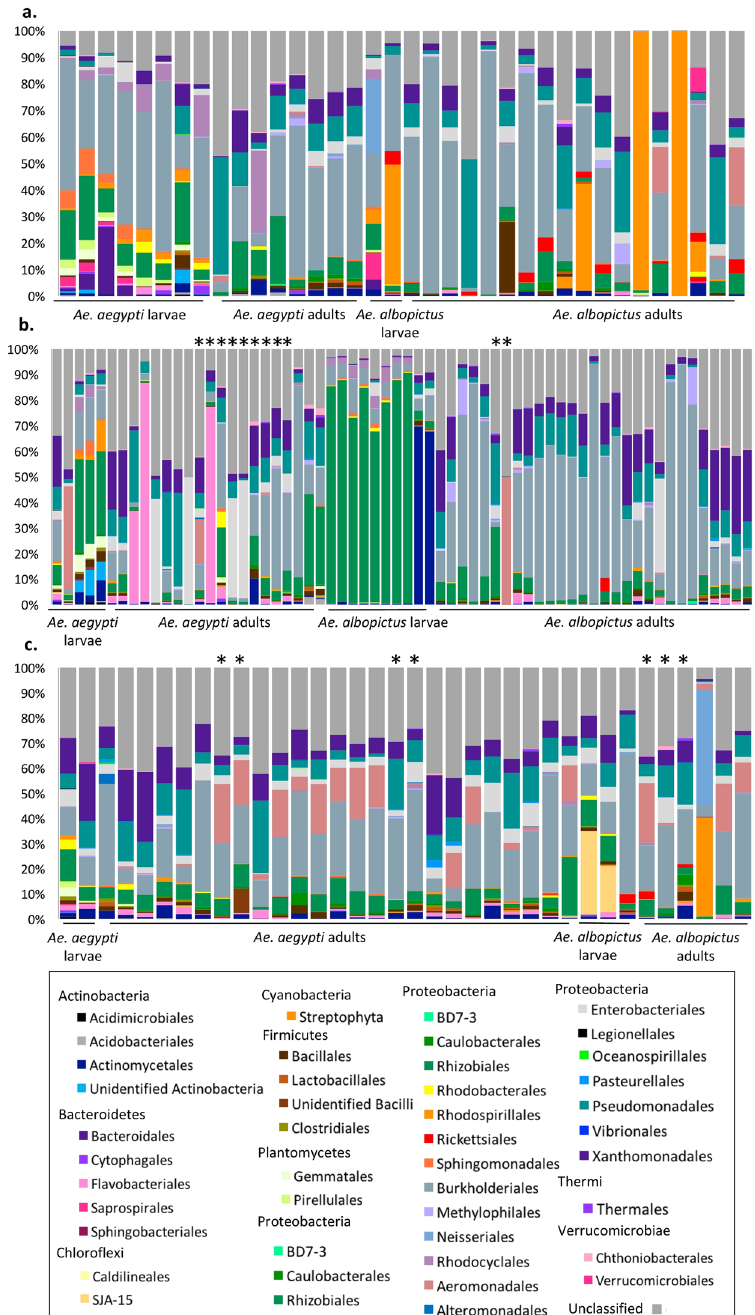
Santos and ( c ). Eastern Panama including Colón, Coclé, Darién and the province of Panama. Bacterial classes with an overall relative abundance of at least 1% within either species are specified. * Indicate an inter-species comparison of equivalent sampling